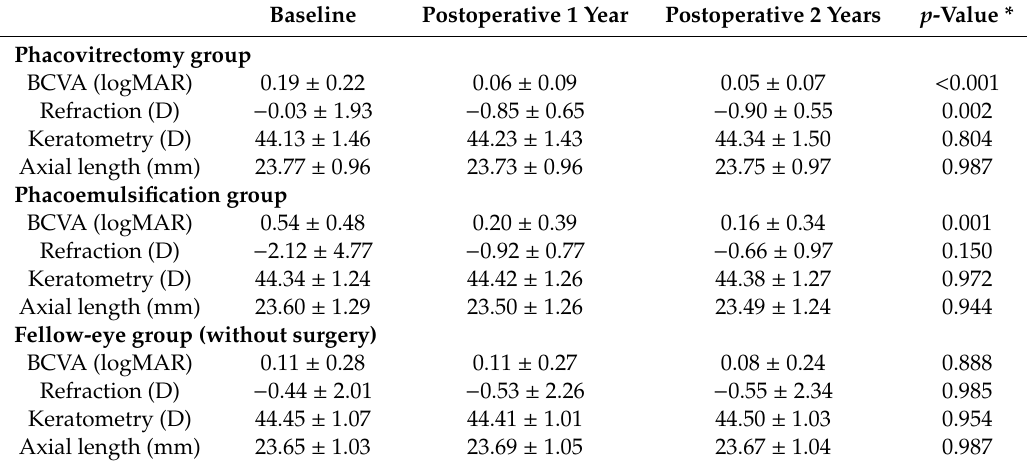
Changes in biometrics over 2 years in the phacovitrectomy, phacoemulsification, and fellow-eye groups.